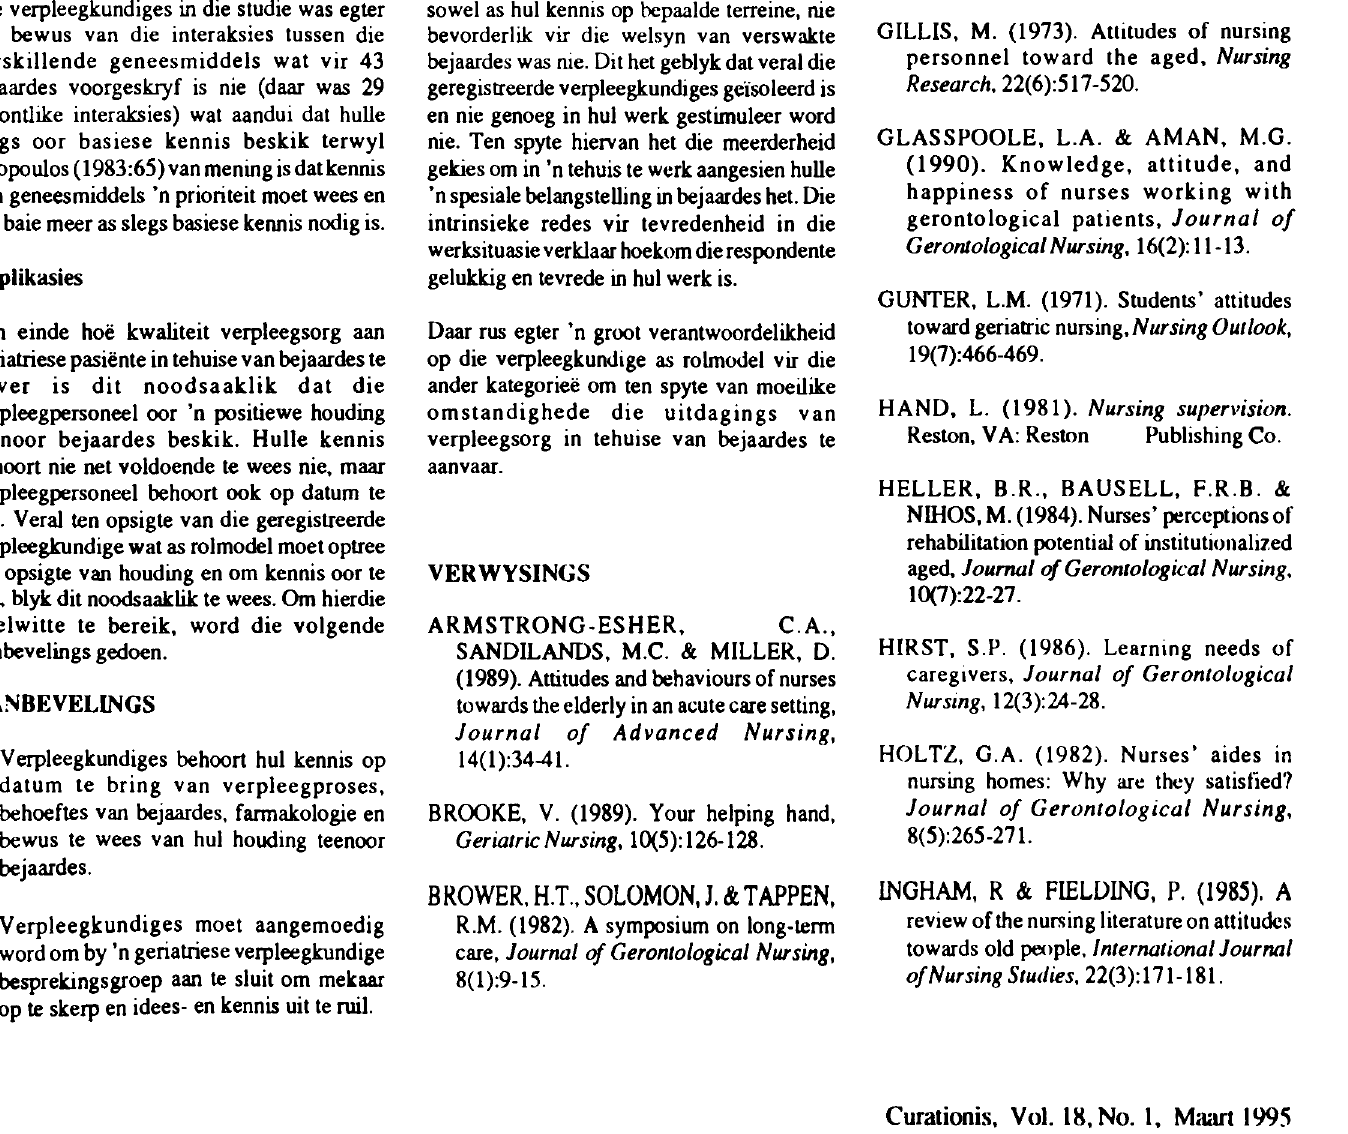
FIGUUR 3: Houding en kennis: Persentasies op 5 punt Likert skaal deur die verpleegpersoneel verkry (N=134) verpleegkundiges dikwels die